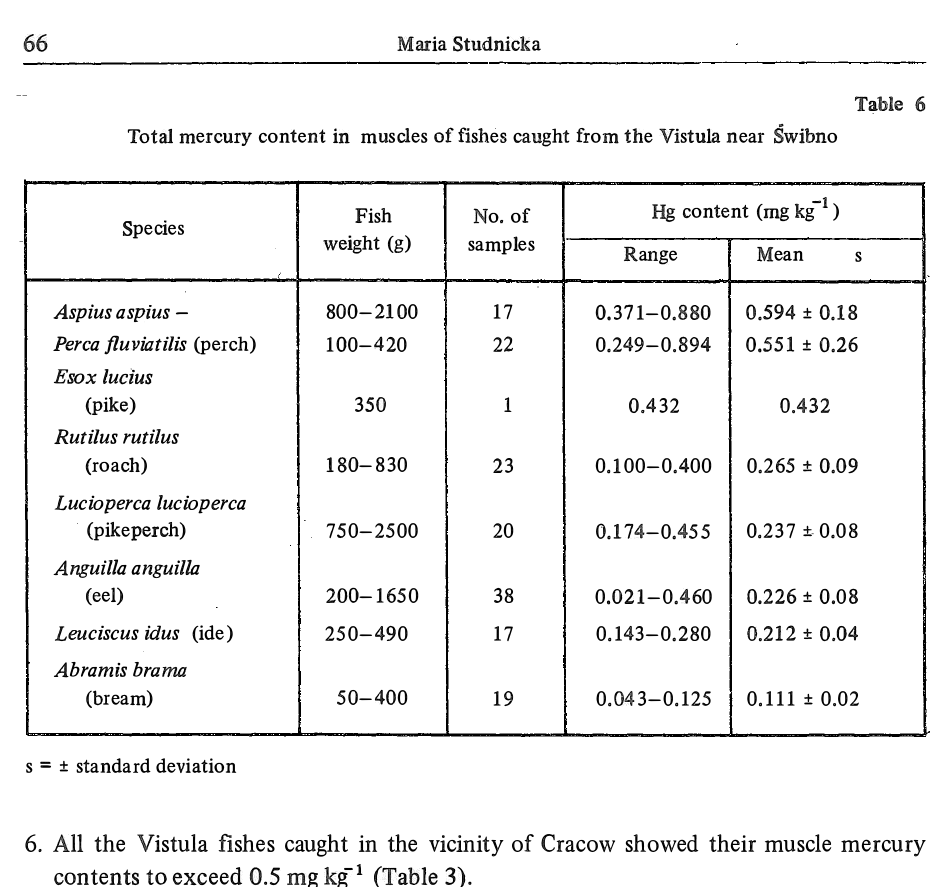
Total mercury content in muscles of fishes caught from the Vistula near